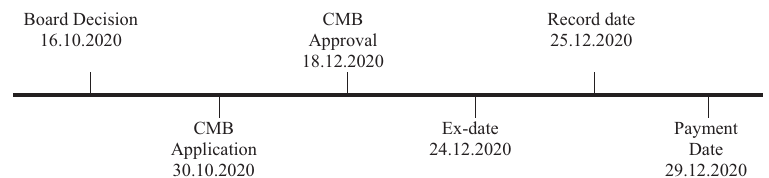
Figure 2. The timeline of a